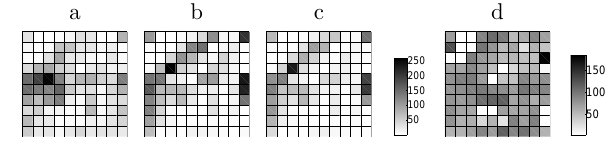
Fig. 11. Spatial distributions of the total bromide leaching during snowmelt, total bromide leaching during irrigation, and total PG leaching during irrigation over the multi-compartment sampler con- sisting of 10 × 10 cells of 3 . 15 × 3 . 15cm 2 each. Bromide leaching during the snowmelt experiment (a) , bromide leaching during the irrigation experiment (b) , PG leaching during the irrigation exper- iment (c) , leaching is given in % from what would have leached in each cell with perfect uniform flow. PG leaching divided by bro- mide leaching during the irrigation experiment (d) , both scaled with the applied solute mass per m 2 , given in %.